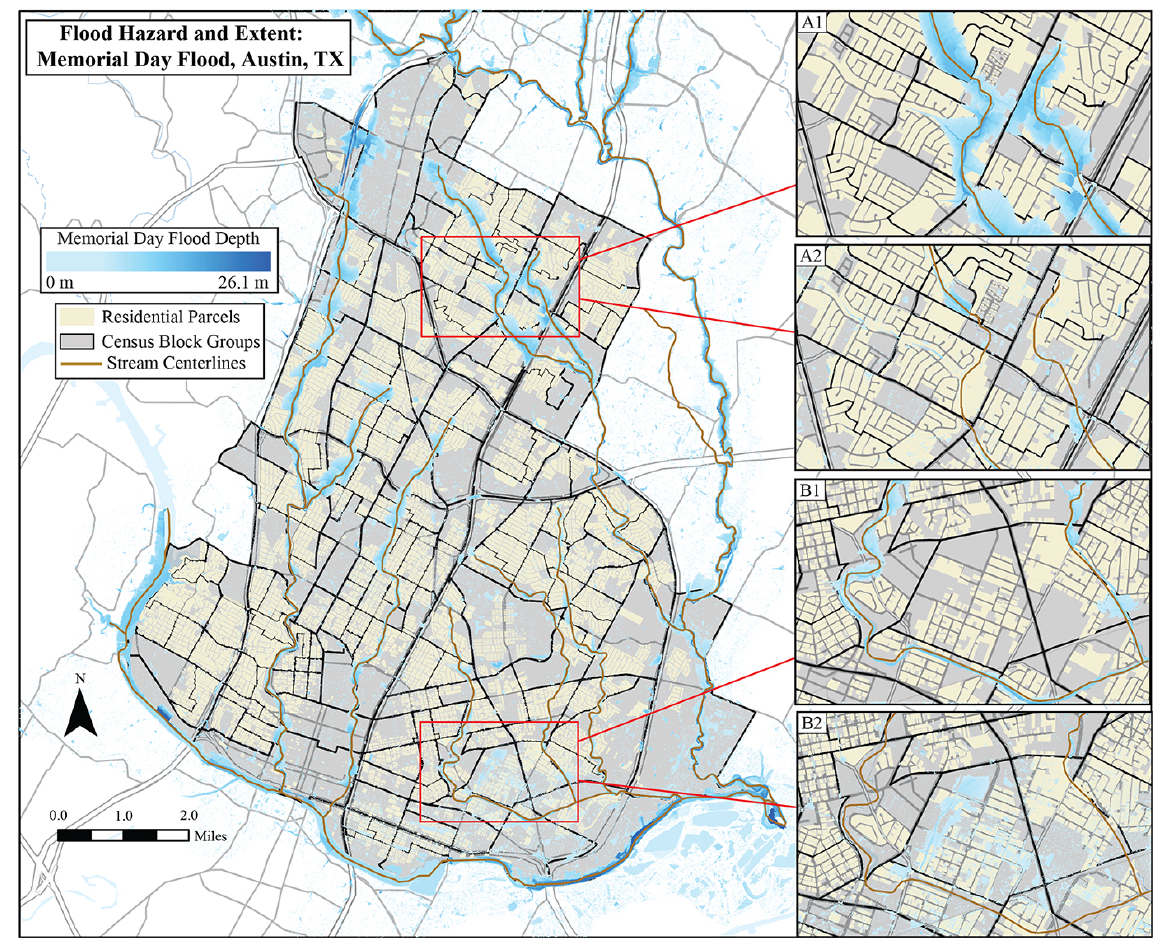
Figure 4. Fluvial and pluvial flood depths and extent in Austin, Texas, during the 2015 Memorial Day flood. Insets A1 and B1 show only the fluvial inundation component, while insets A2 and B2 show only the pluvial inundation component of the flood